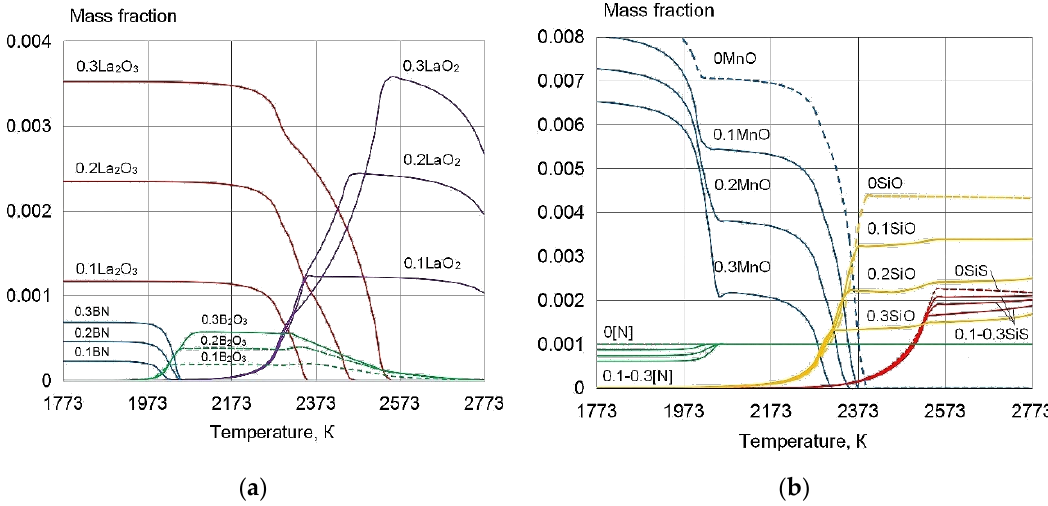
Figure 5. The equilibrium phase composition of the weld pool of 316L type, wt%: 0.03C, 0.5Si, 2.0Mn, 19.0Cr, 12.0Ni, and 3.0Mo in the addition of La and B: ( a ) La 2 O 3 , LaO 2 , B 2 O 3 , BN; ( b ) MnO, SiO, SiS, (N). Corresponding contents of La and B are indicated before compounds, wt%: (0) without REE; (0.1) (0.1La+0.01B); (0.2) (0.2La+0.02B); (0.3) (0.3La+0.03B).